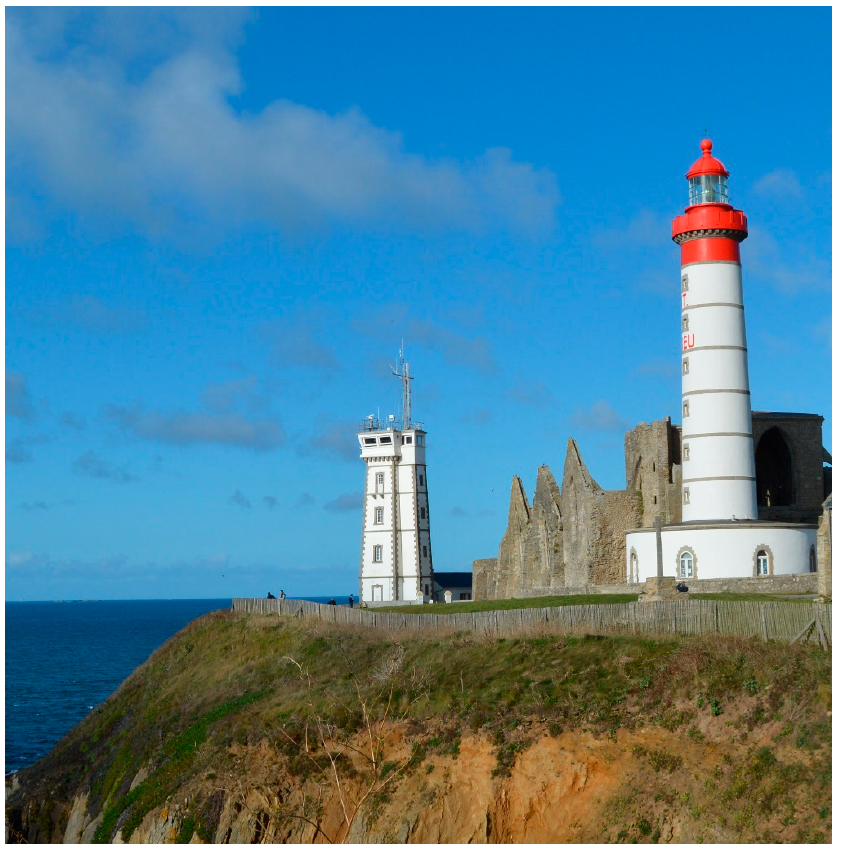
Figure 1. Saint-Mathieu sémaphore and lighthouse, with permission from Clémentine Cardon, 2021.